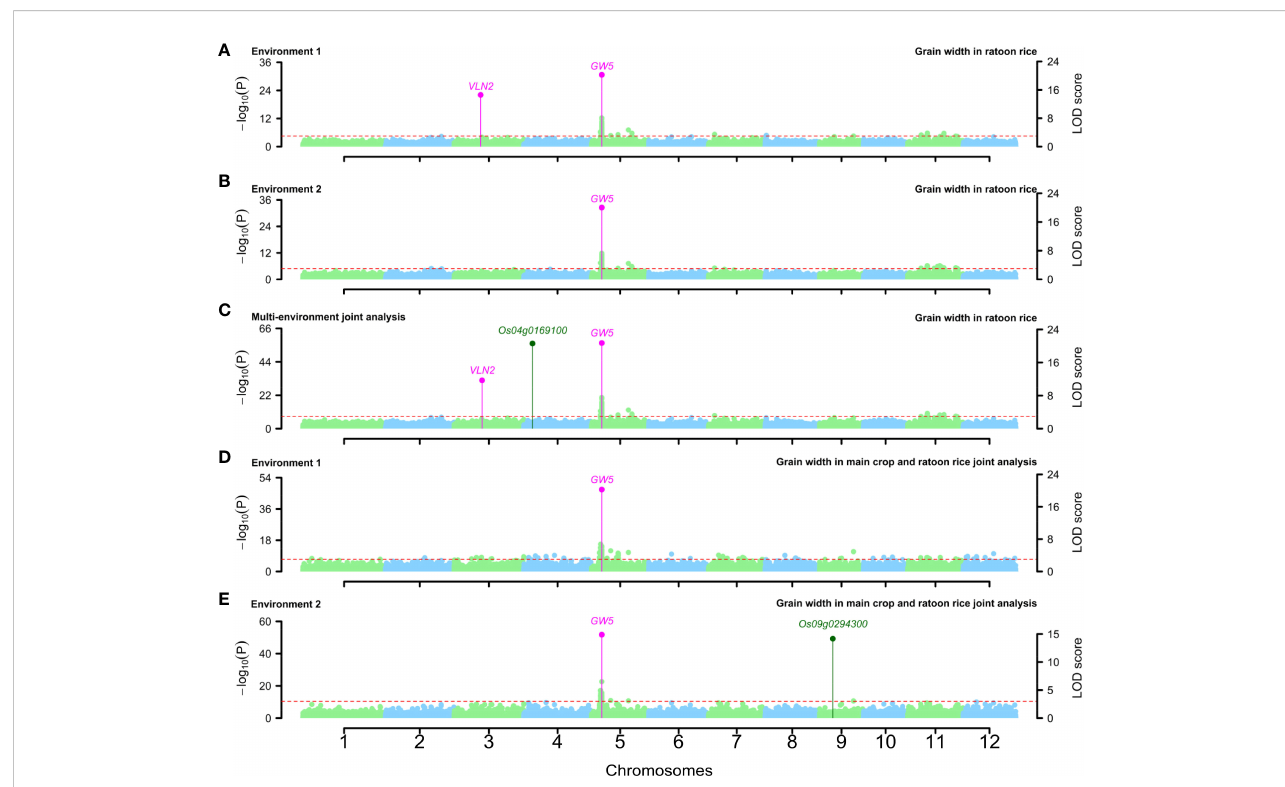
FIGURE 3 Manhattan plots for grain width in ratoon rice (A – C) and grain width in the joint analysis of main crop and ratoon rice (D, E) . Known genes around QTNs were marked with magenta color, and candidate genes around QTNs were marked with dark green